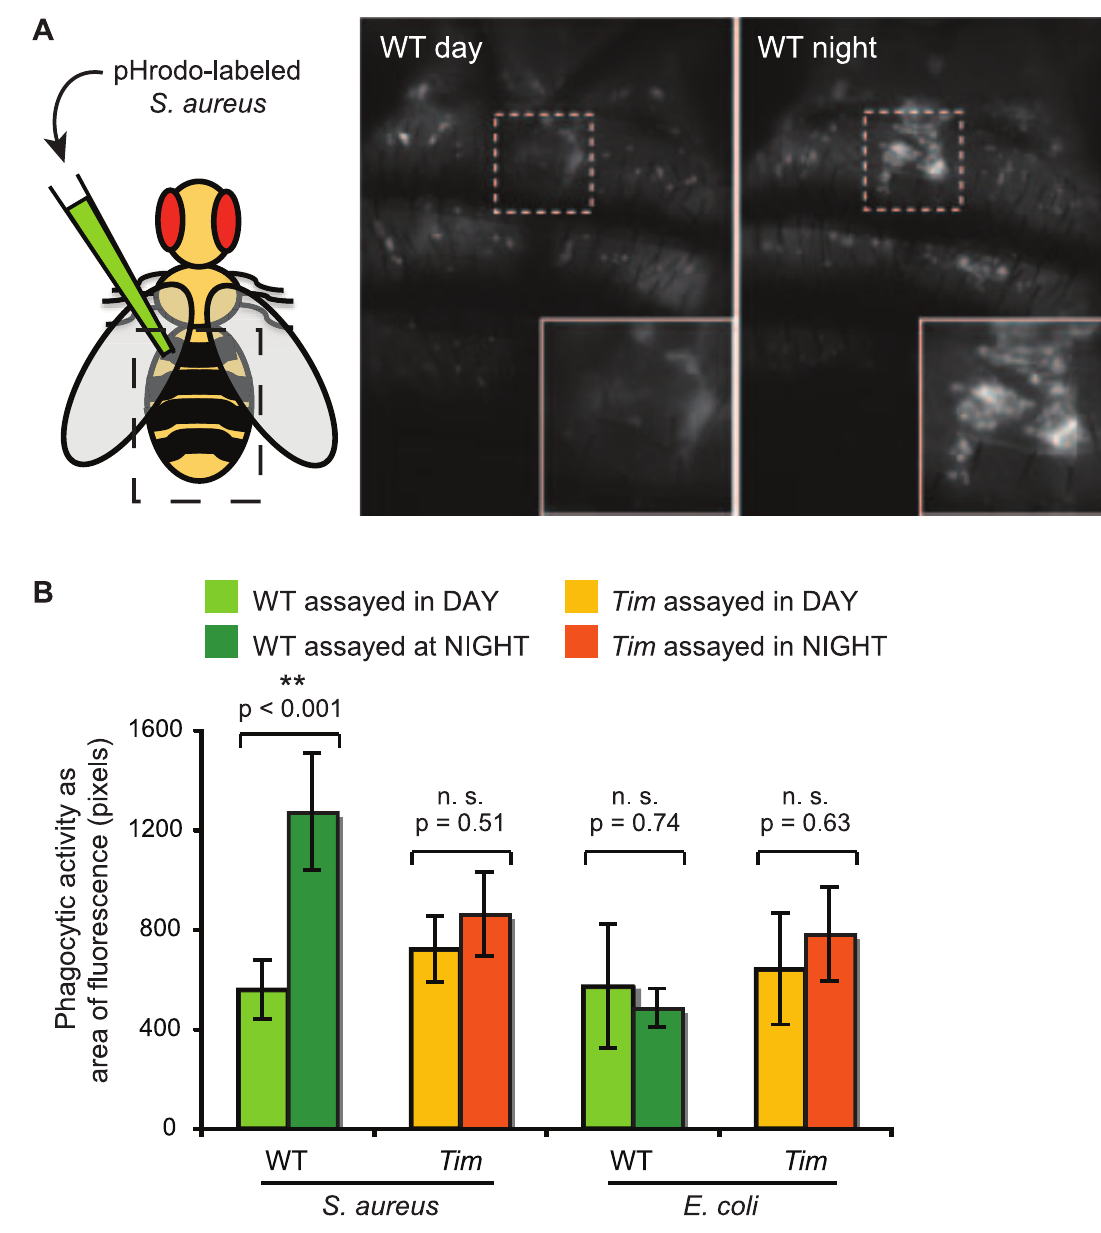
Figure 5. Tim protein regulates an early stage of phagocytosis of bacteria by hemocytes. (A) Wild-type flies in the night phase of the circadian cycle have more phagocytic activity than wild-type flies in the day phase. Shown here are images of the dorsal surface of representative flies after injection of dead S. aureus labeled with the fluorophore, pHrodo, which emits fluorescence in acidic environments such as the lysosomes. Hemocytes that have phagocytosed these bacteria become fluorescent. Dashed lines indicate the region enlarged in the inset. (B) Phagocytic activity for wild type and Tim mutant flies was quantified by measuring areas of fluorescence. Wild-type flies exhibited significant circadian differences in phagocytosis of S. aureus (p , 0.001) but not E. coli (p=0.74). This circadian difference is not present in Tim mutant flies with either S. aureus (p=0.51) or E. coli (p=0.63). p-values were obtained by unpaired, two-tailed t-test.